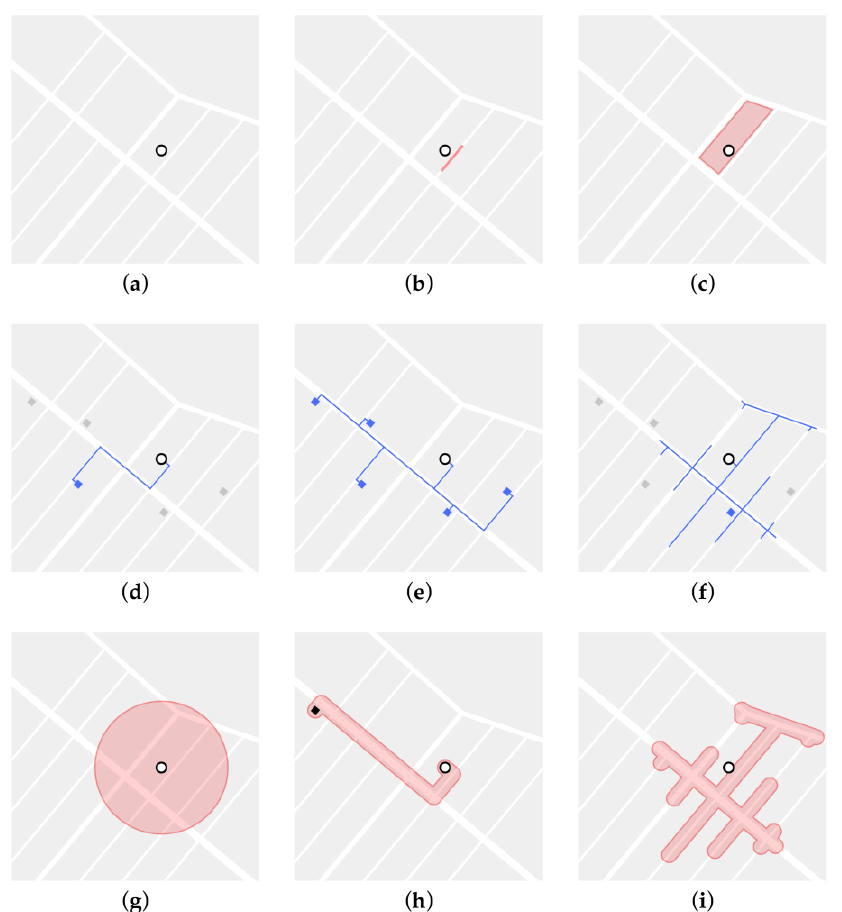
Figure 2. Different methods quantifying environmental exposure at varying spatial relationships: at